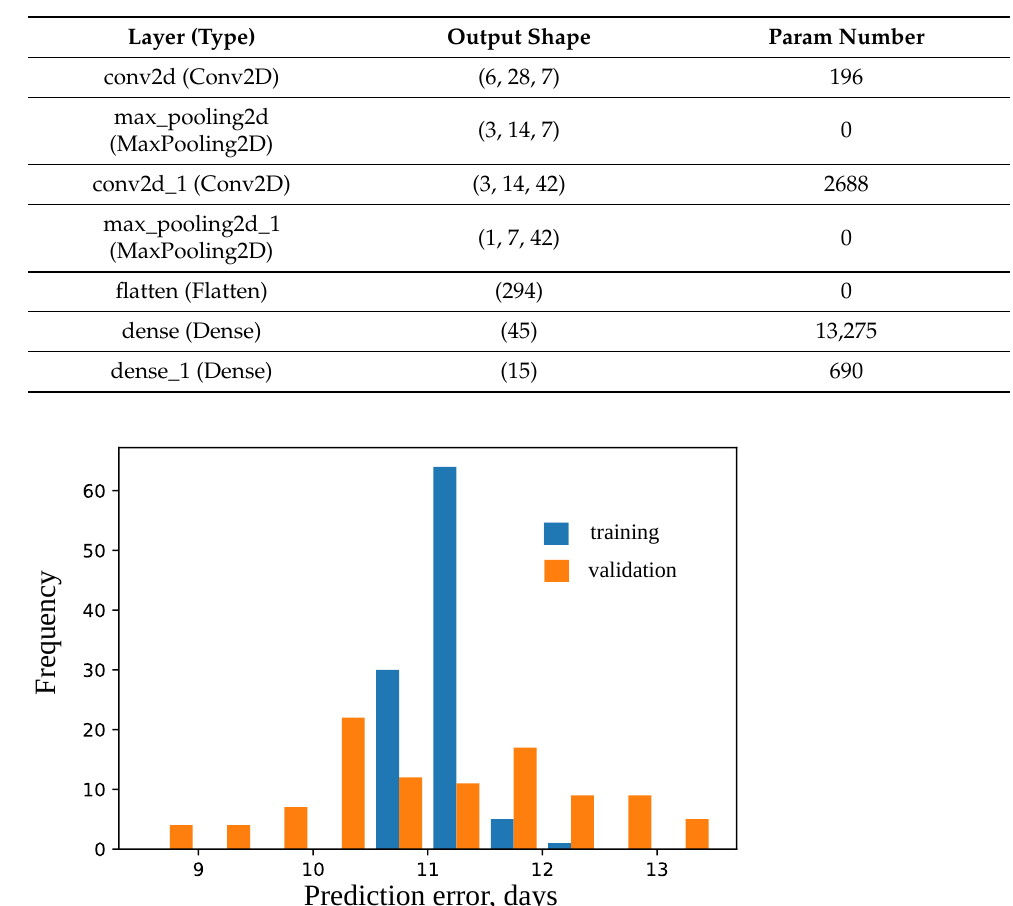
Table 3. Model architecture for the cross-SNP set.The types and names of the layers of the constructed CNN are given in the first column, while the number of outgoing connections and the number of trainable parameters are in the second and the last column, respectively (see details in Section 3.6).